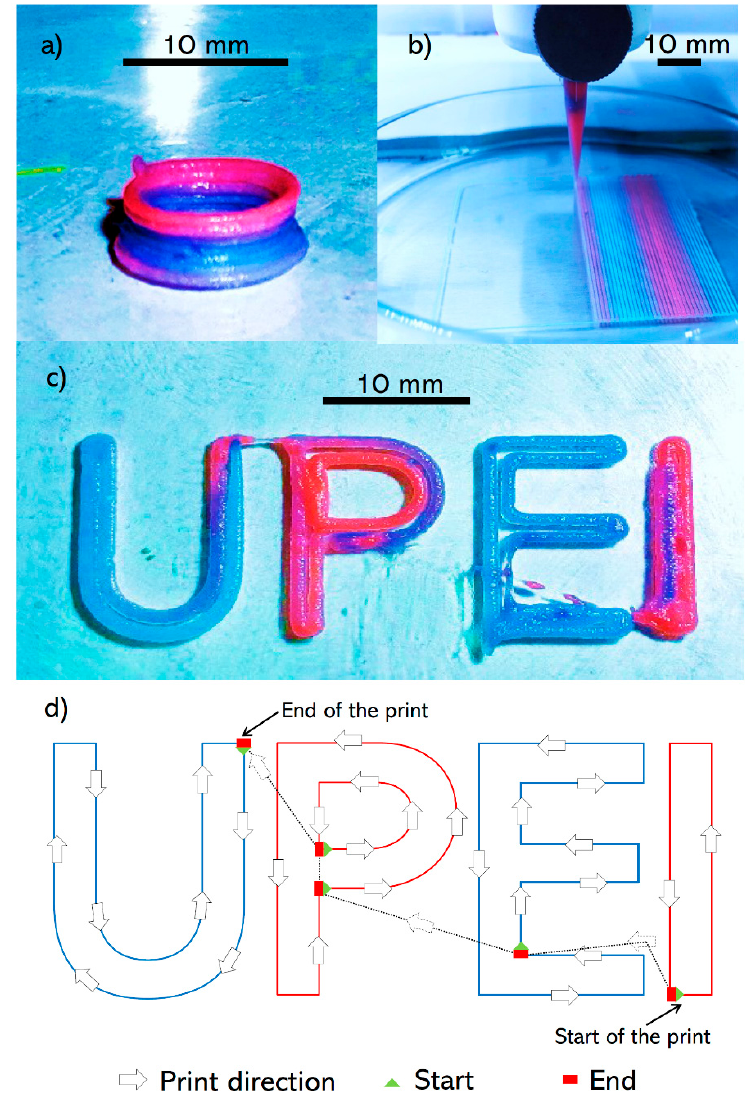
Figure 4. Di ff erent geometries printed with the SNMM printhead: ( a ) cylinder (10 mm diameter, 5 mm height) using a 430 µ m nozzle, ( b ) square (50 mm × 50 mm) using a 200 µ m nozzle and ( c ) UPEI letters using a 430 µ m nozzle. ( d ) Printhead path and transition of bioinks in UPEI letters.